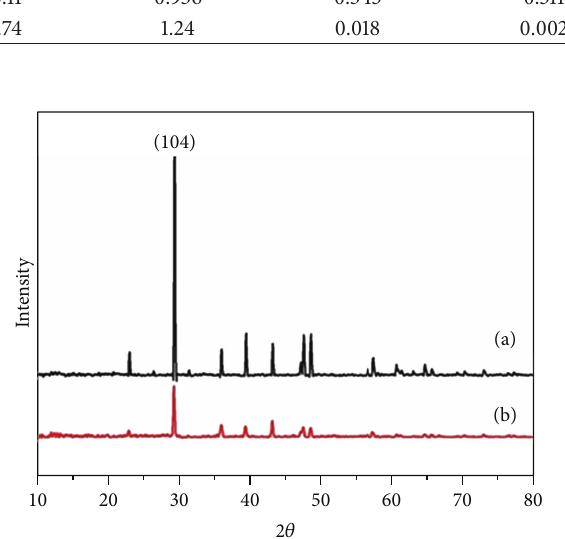
Figure 1: X-ray diffraction pattern of (a) eggshell and (b) commer- cial calcium